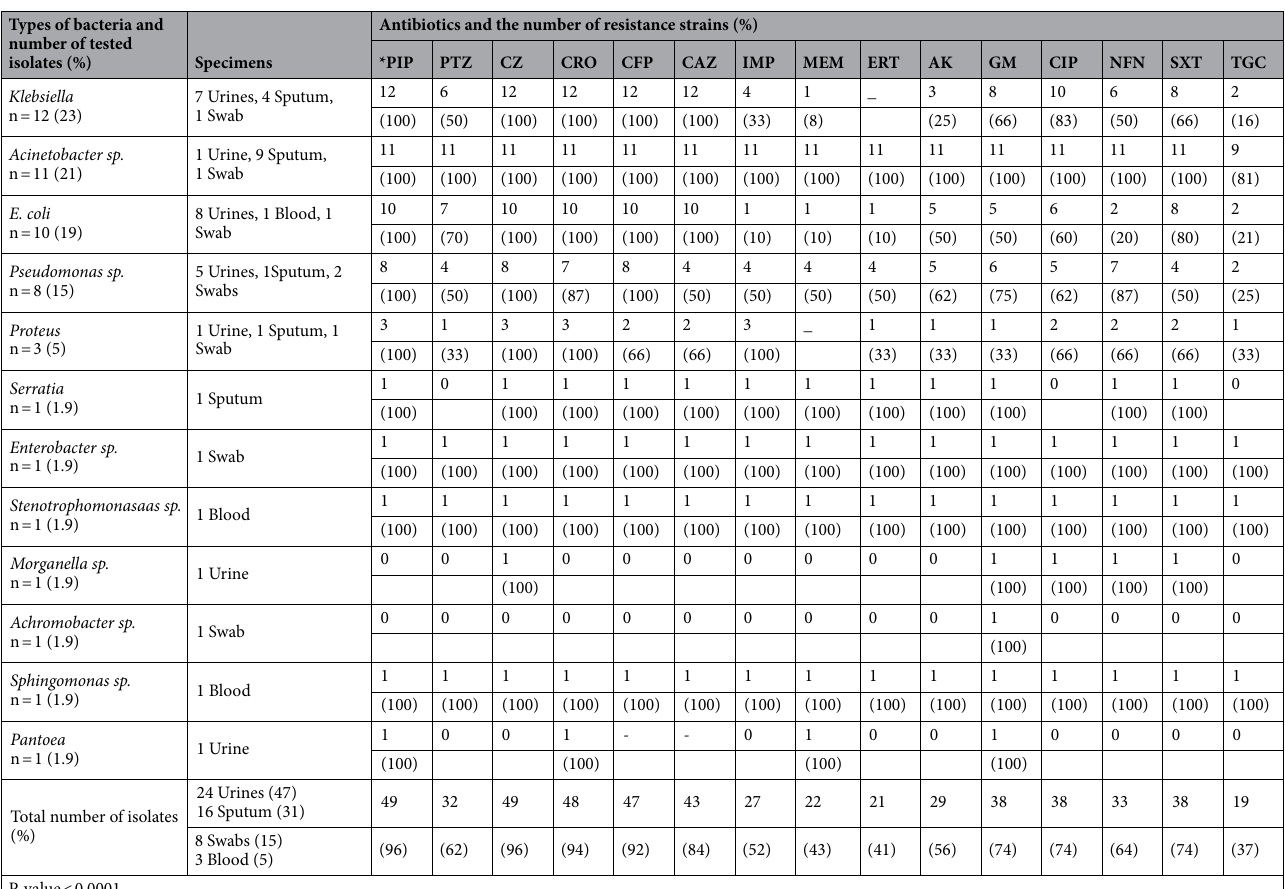
Table 1. Samples distribution and sensitivity rate of 51 CPGB. *Piperacillin (PIP), piperacillin-tazobactam (TPZ), ceftriaxone (CRO), ceftazidime (CAZ), cefazoline (CZ), cefepime (FEP), gentamicin (GM),